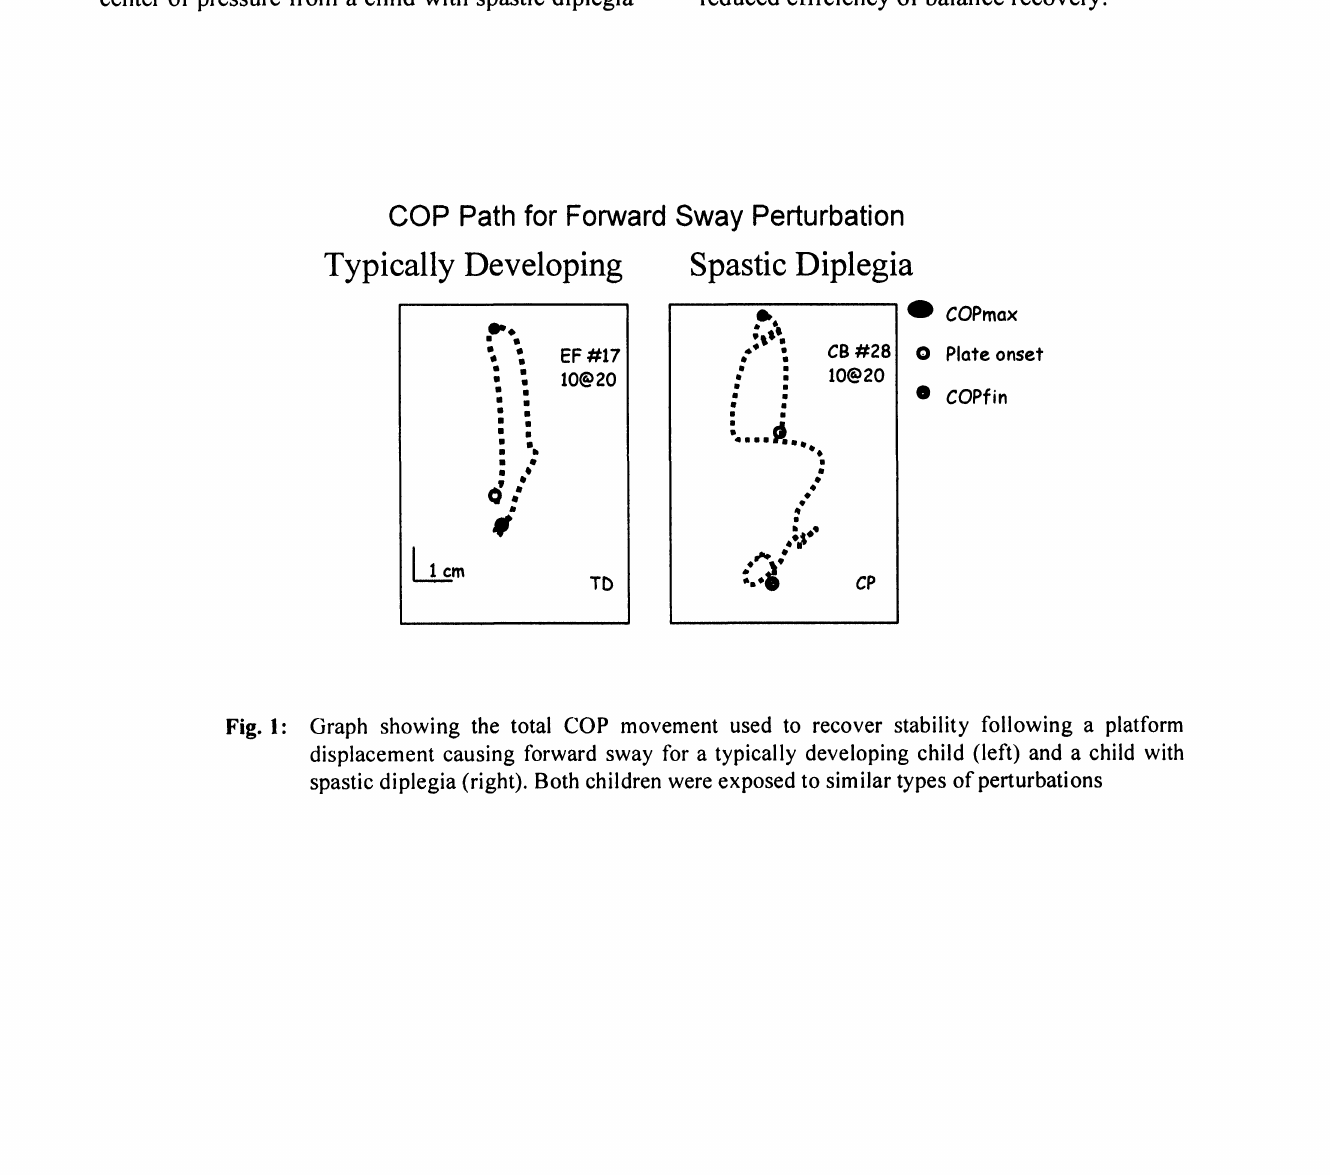
shows an example of the movement of the center of pressure from a child with spastic diplegia